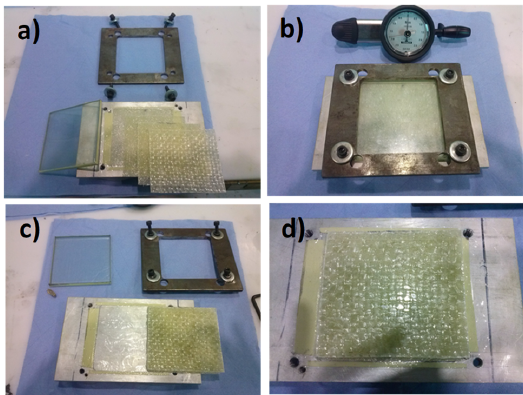
Figure 2. Experimental set-up for the compaction and curing of the final composite part. ( a ) prepregs layout; ( b ) composite manufacturing by compression step; ( c ) glass plate, metal frame, metal surface and composite layout; ( d ) final composite part.